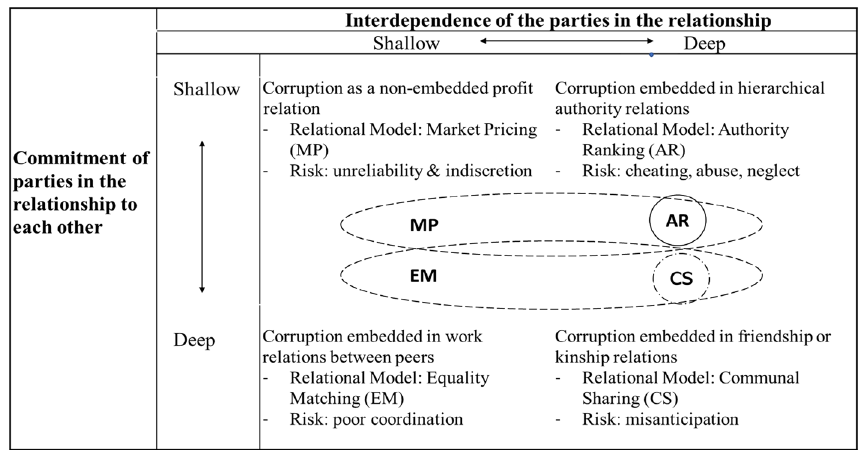
Table 1 Relational model theory and the degree of dependence relations in corruption. Source : Adapted from Fiske (1991) and Ryan and Blois